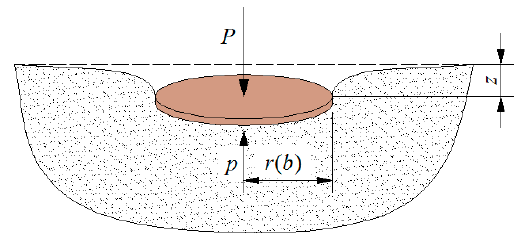
Figure 2. Schematic diagram of soil pressure-sinkage.